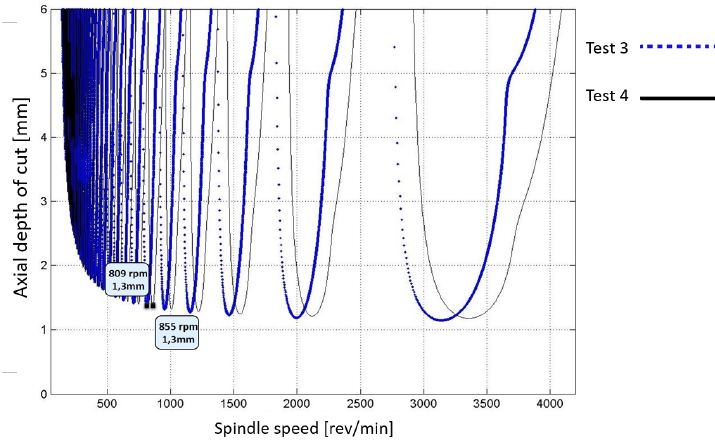
Fig. 9. Stability lobes diagram for experiments 3 and 4.